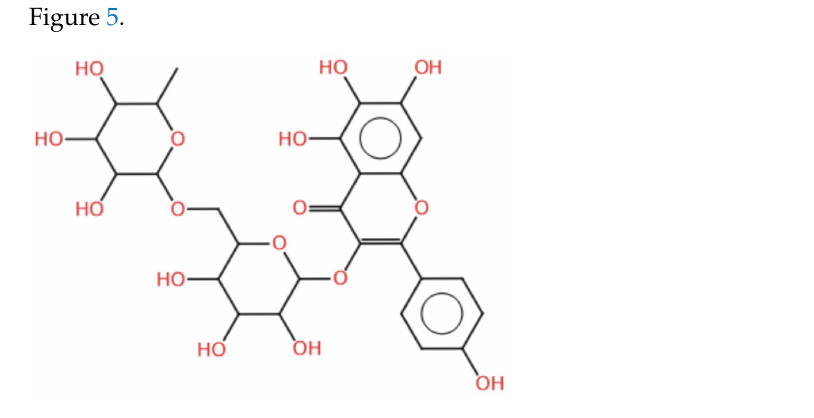
Figure 5. Common scaffold structure found through the sequence alignment of all ten flavonoids.